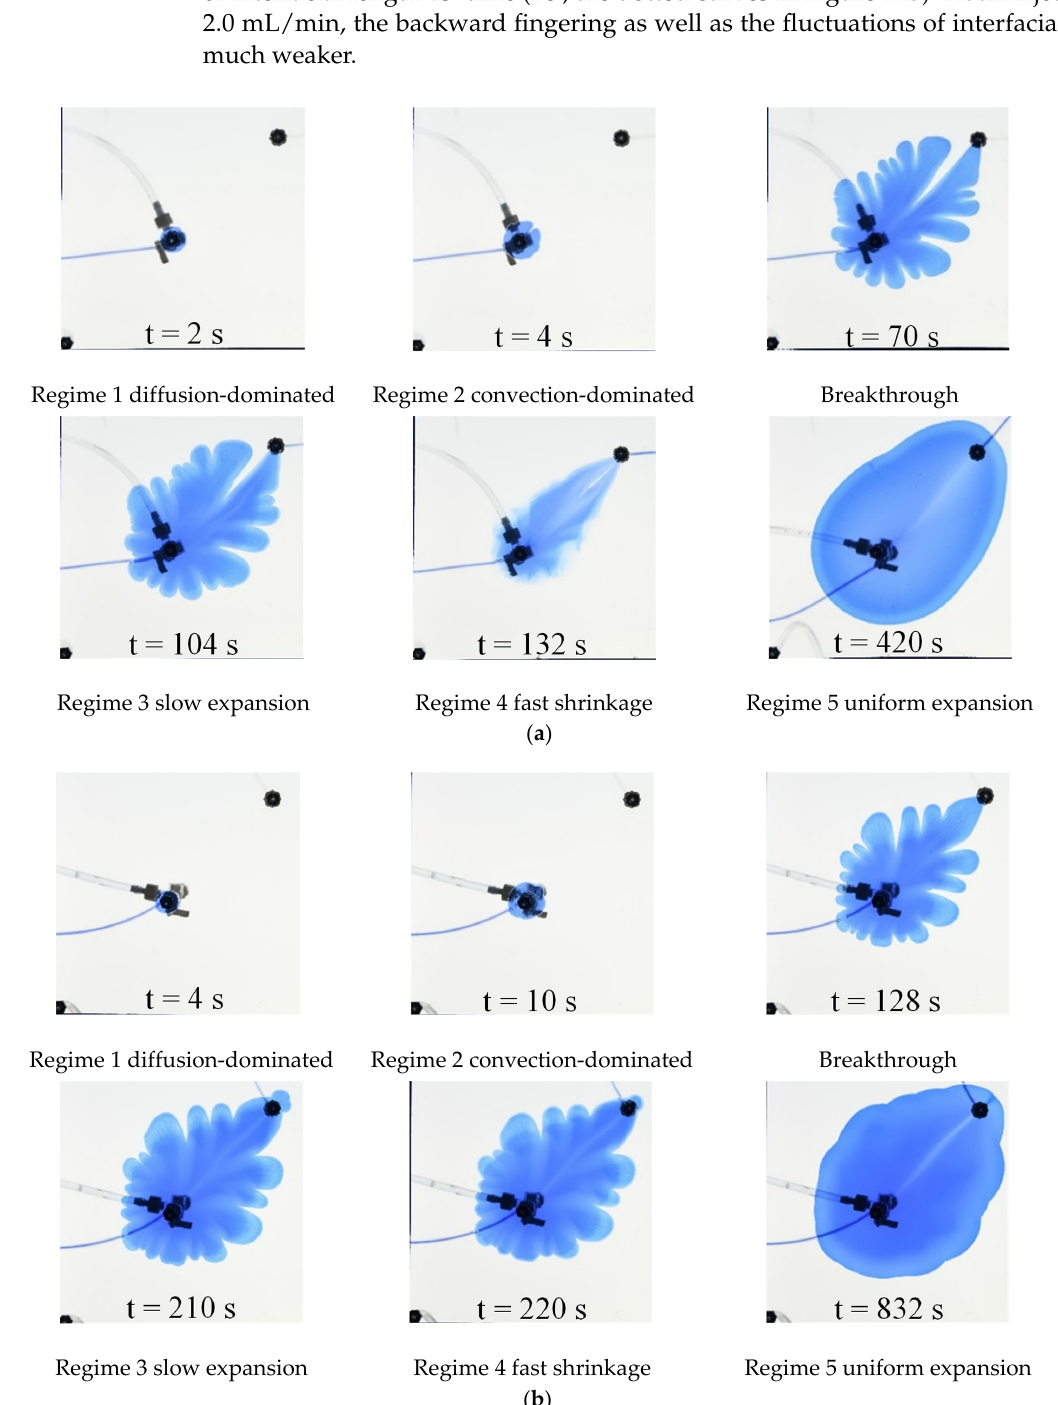
Figure 10. Water plumes at the end of reach regime with constant production rate control at the outlet. ( a ) Five regimes at 5.0 mL/min; ( b ) Five regimes at 2.0 mL/min.